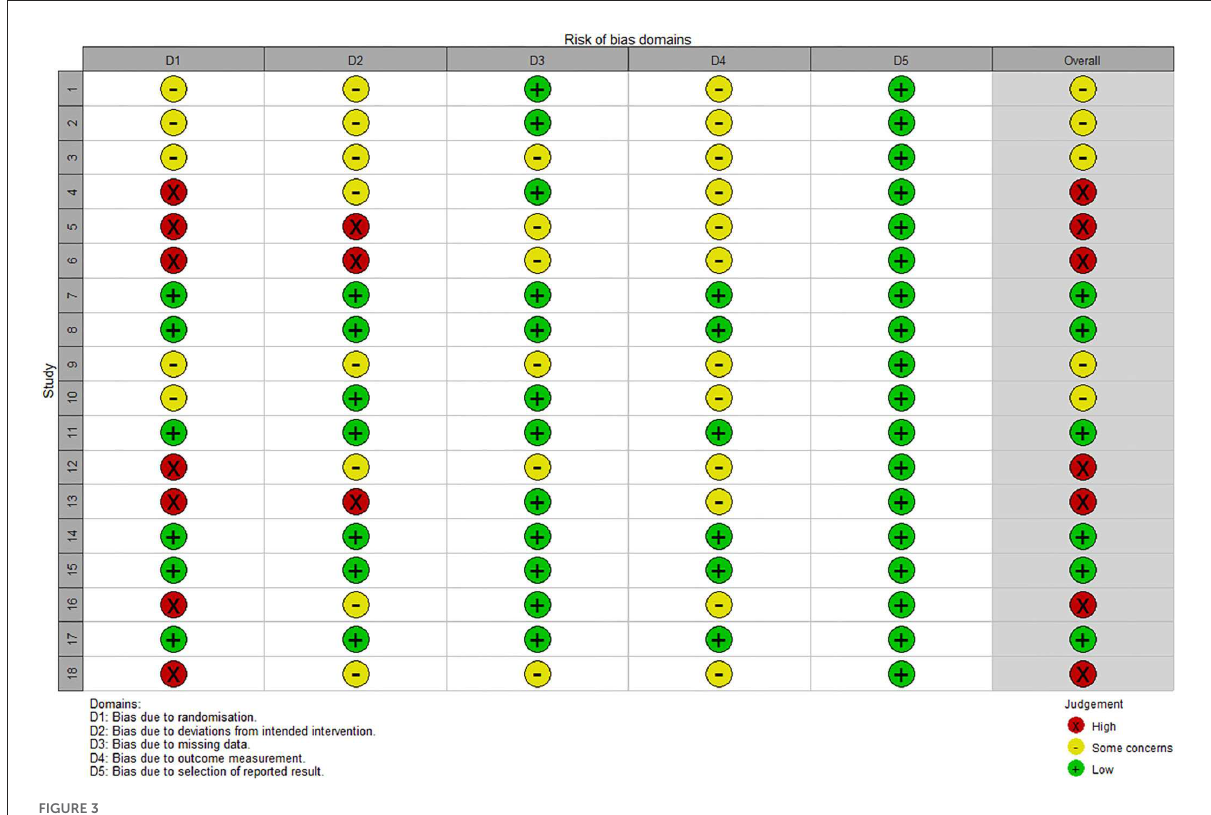
FIGURE3 Risk of bias